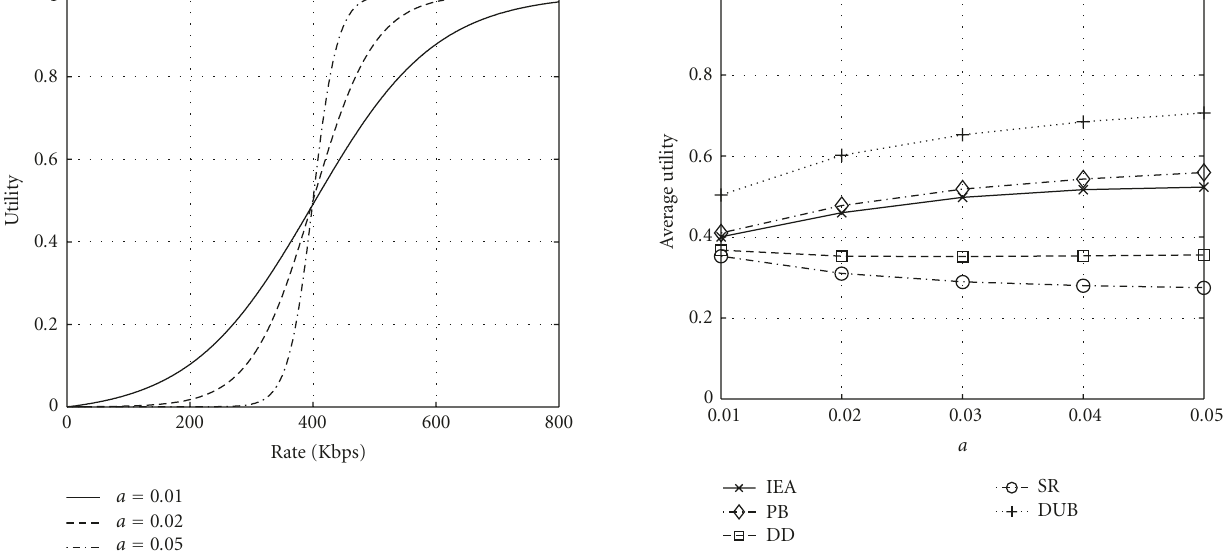
Figure 3: Sigmoid utility function, b = 400Kbps .